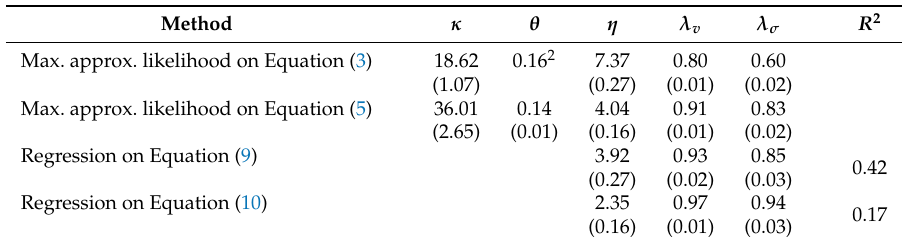
Table 2. Estimated parameters under each of the four estimation methods discussed. Standard errors are shown in parenthesis where applicable.